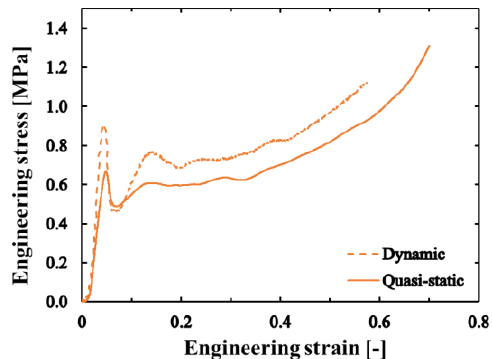
Fig. 5. The stress-strain curve in the case of expansion ratio of 12.